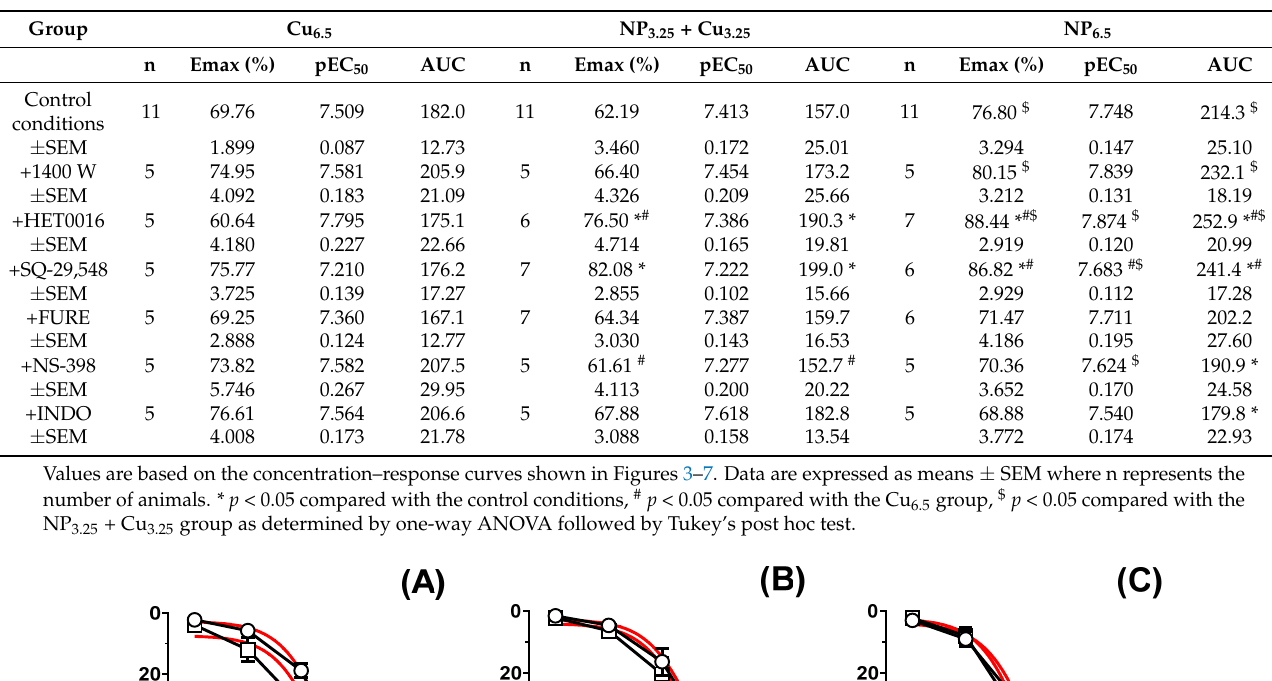
Table 1. The influence of iNOS inhibitor (1400 W, 1.0 µ M), the selective COX-2 inhibitor (NS-398, 10 µ M), the non-selective COX-1/2 inhibitor (indomethacin, 10 µ M), the inhibitor of 20-HETE formation (HET0016, 0.1 µ M), the thromboxane-A 2 synthase inhibitor (furegrelate, 1.0 µ M), and the thromboxane receptor antagonist (SQ-29,548, 1.0 µ M) on the vasorelaxant effects to acetylcholine of thoracic arteries from Wistar–Kyoto rats supplemented with Cu 6.5 , NP 3.25 + Cu 3.25 and NP 6.5 .